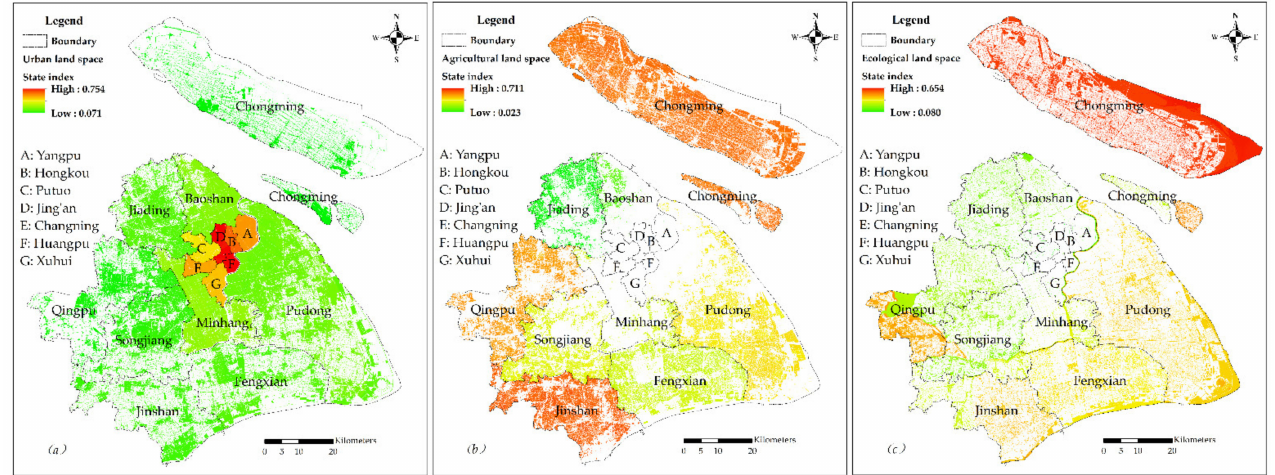
Figure 3. The carrying capacity evaluation values of the three subspaces in Shanghai. ( a ) the carrying capacity state index of urban land space; ( b ) the carrying capacity state index of agricultural land space; ( c ) the carrying capacity state index of ecological land